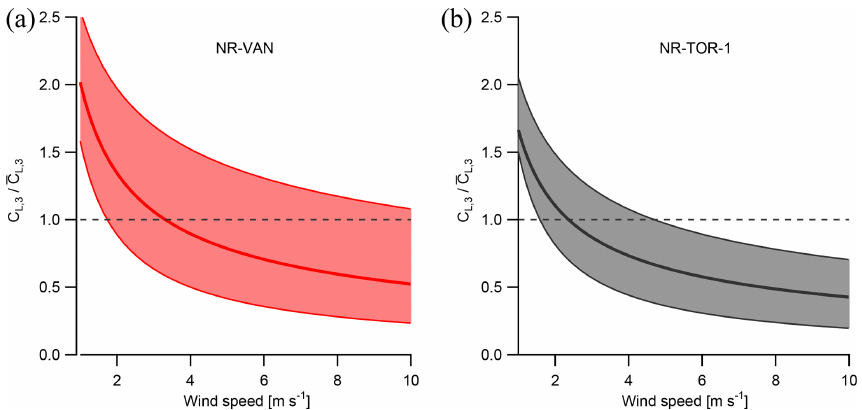
Figure 6. Normalized local pollutant concentrations determined using method 3 as a function of wind speed at NR-VAN (a) and NR-TOR-1 (b) . Solid lines indicate the average trend amongst all TRAPs, and shaded areas indicate the range of variability between TRAPs.